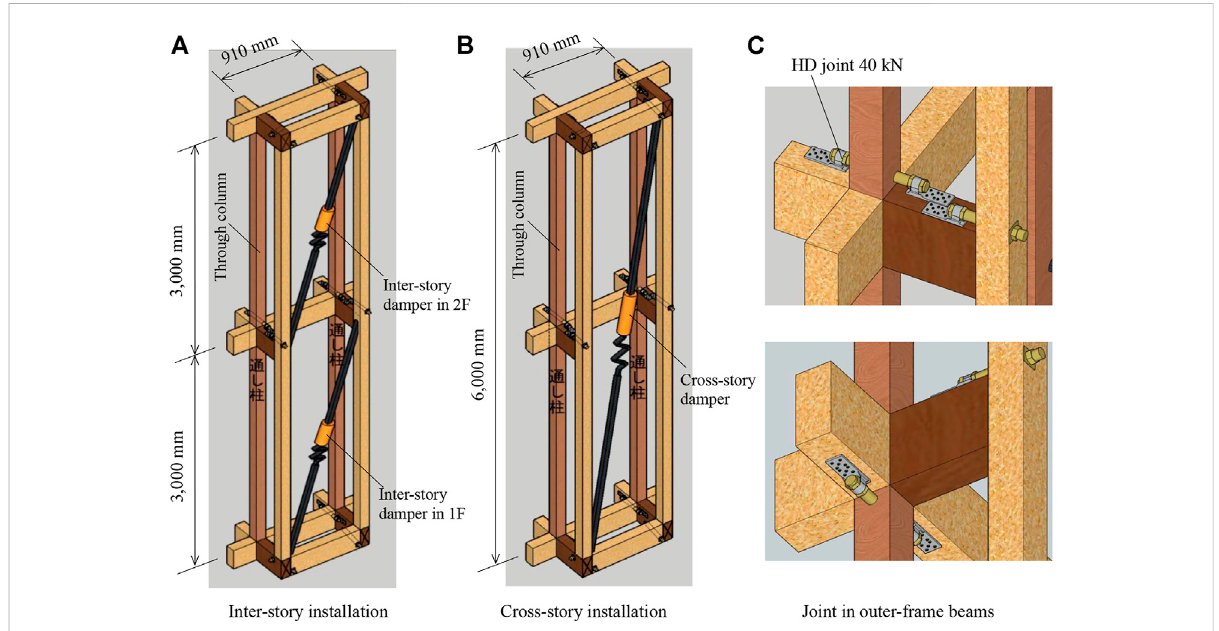
FIGURE 8 Installation of viscous dampers in the timber frame house (A) Inter-story installation (B) Cross-story installation (C) Joint in outer-frame beams.